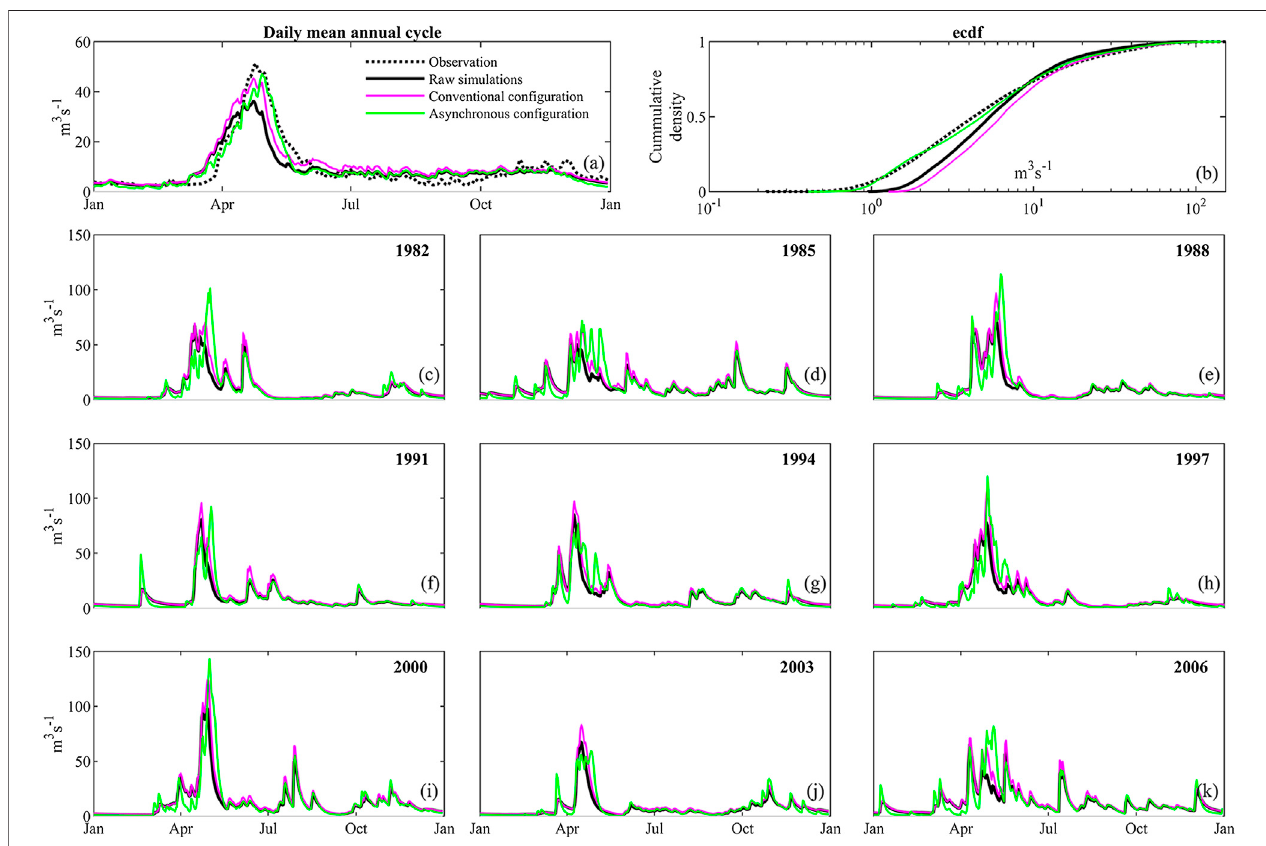
FIGURE 5 | Stream fl ow simulations issued by CRCM5-LE climate simulations forcing the WaSiM-ETH hydrologic model over Du Loup catchment between 1980 and 2009. First row presents daily mean annual cycles and corresponding empirical cumulative distribution functions (ecdf) of daily values. Stream fl ow observations (dashed black) are given as reference. Following rows present a sample of simulated annual hydrographs (time step of 3 years, from 1980 to 2009). Stream fl ow simulations issued by conventional (magenta) and asynchronous (green) con fi gurations of the hydroclimatic modeling chain are compared to raw climate simulations (full